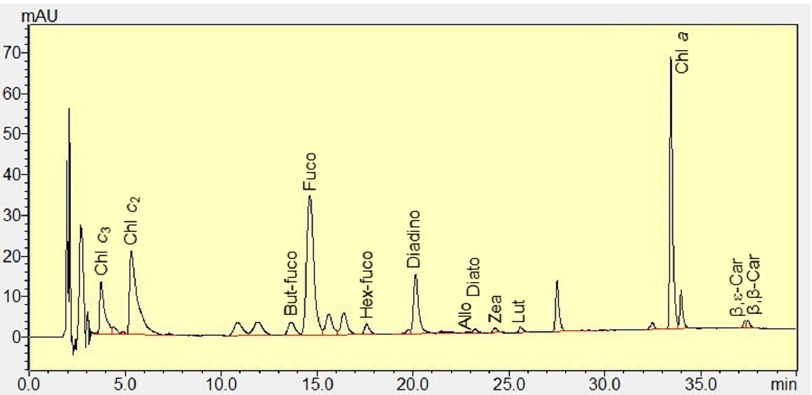
Figure 6. Pigment profiles of Karenia mikimotoi analyzed through HPLC. A total of 13 pigments is observed: chlorophyll c 3 (Chl c 3 ), chlorophyll c 2 (Chl c 2 ), 19 ′‐ butanoyloxyfucoxanthin (But ‐ fuco), fucoxanthin (Fuco), 19 ′‐ hexanoyloxyfucoxanthin (Hex ‐ fuco), diadinoxanthin (Diadino), alloxanthin (Allo), diatoxanthin (Diato), zeaxanthin (Zea), lutein (Lut), chlorophyll a (Chl a ), β , ε‐ carotene ( β , ε‐ Car), and β , β‐ carotene ( β , β‐ Car).